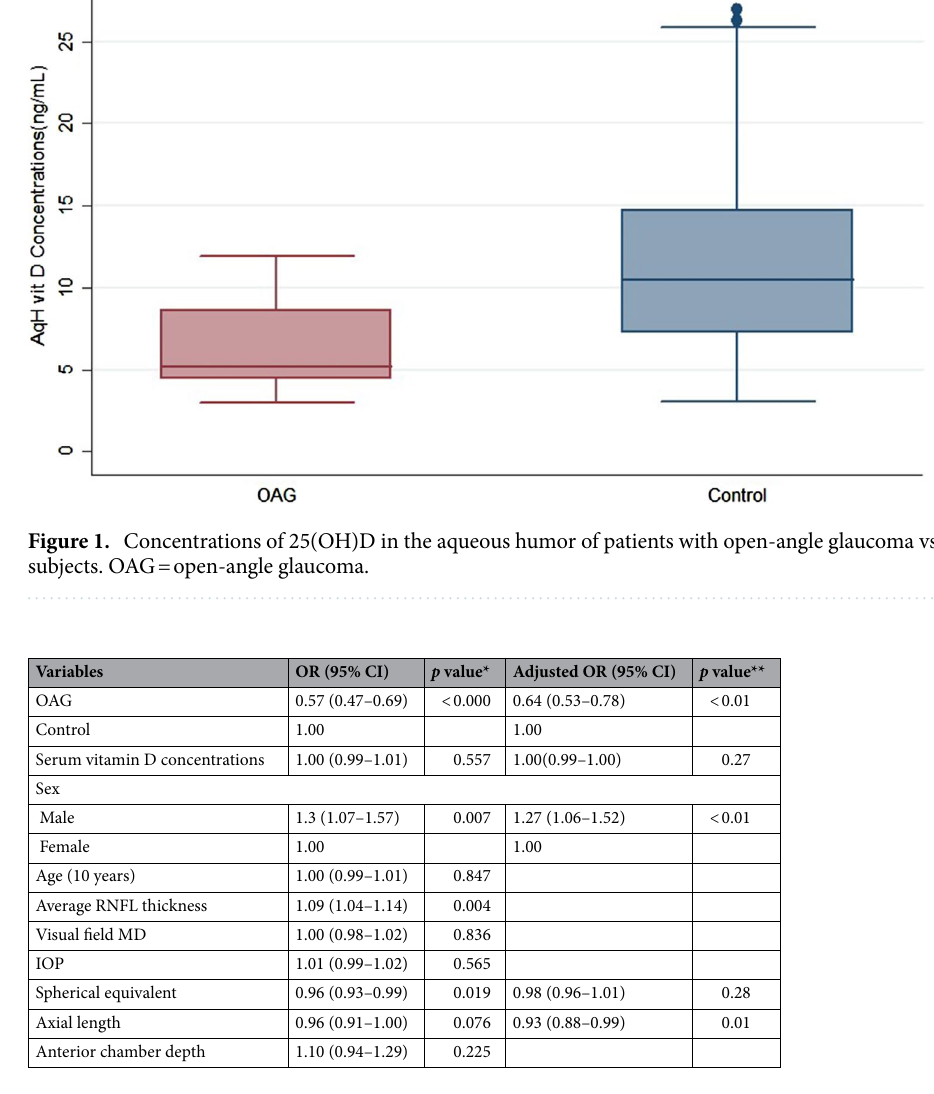
Table 2. Multivariate linear regression analysis of factors associated with 25(OH)D concentrations in the aqueous humor (in all patients). OAG open-angle glaucoma, RNFL retinal nerve fiber layer, MD mean deviation, IOP intraocular pressure, CI confidence interval, OR odds ratio. *Simple linear regression, **multiple linear regression.